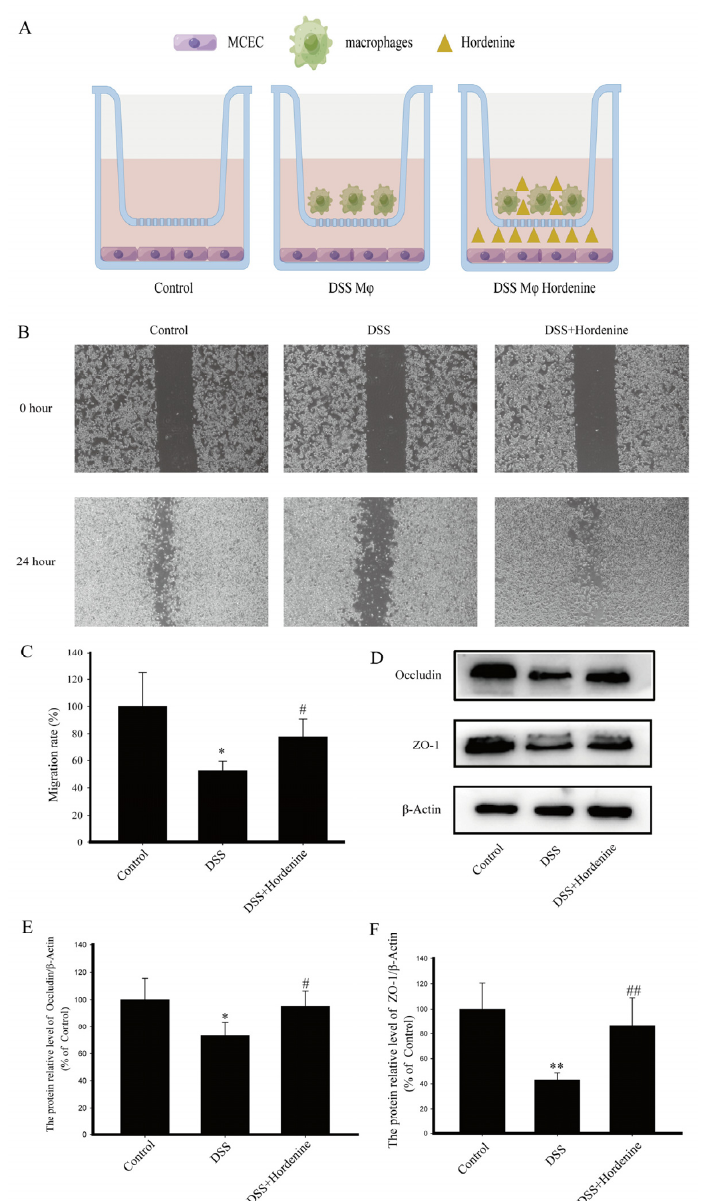
Figure 4. Hordenine (50 mg/kg) affects intestinal epithelial tight junctions. ( A ) Schematic diagram of cell co-culture system. The elements in the graph are derived from figdrow. ( B , C ) Scratch experiments showed the migration capacity of MCECs after hordenine treatment. * p < 0.05 vs. control group; # p < 0.05 vs. DSS group. ( D – F ) Western blotting analysis of occludin and ZO-1 expression in MCECs. * p < 0.05, ** p < 0.01 vs. control group; # p < 0.05, ## p < 0.01 vs. DSS group.